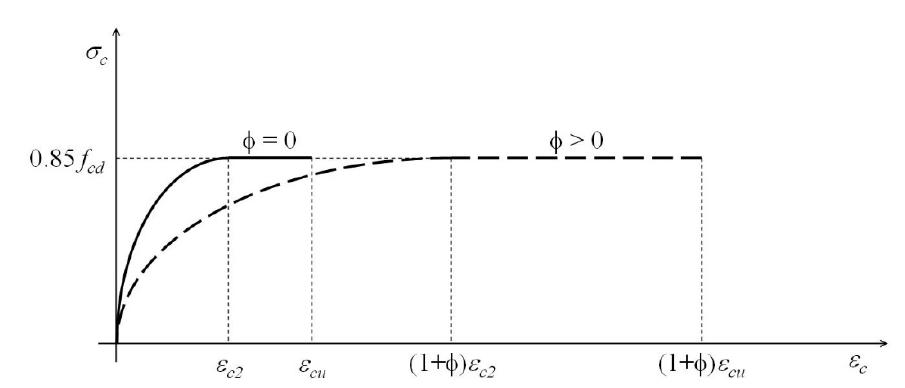
Figure 5. Simplified stress-strain diagram of concrete with